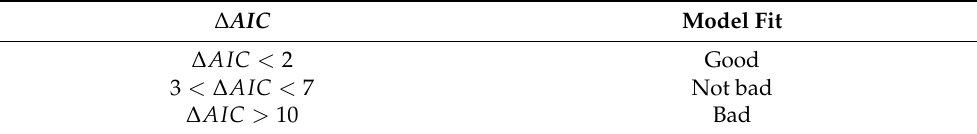
Table 11. Criteria for determining model suitability [24].